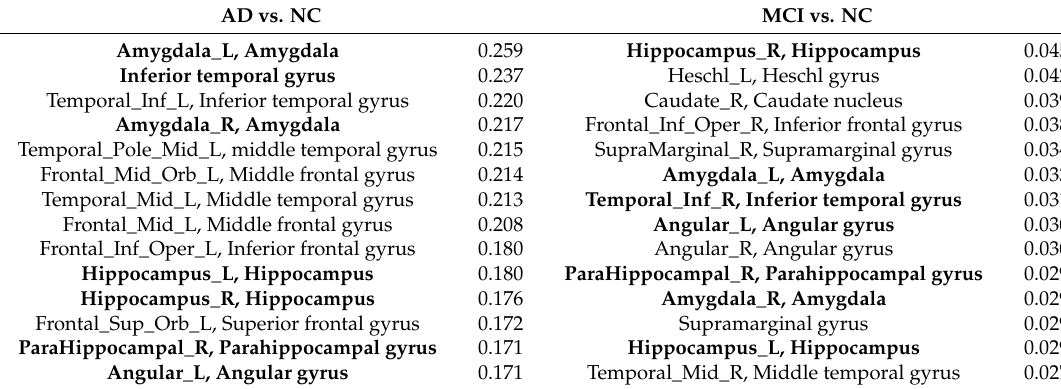
Table 3. The top 15 Information gains of anatomical region.